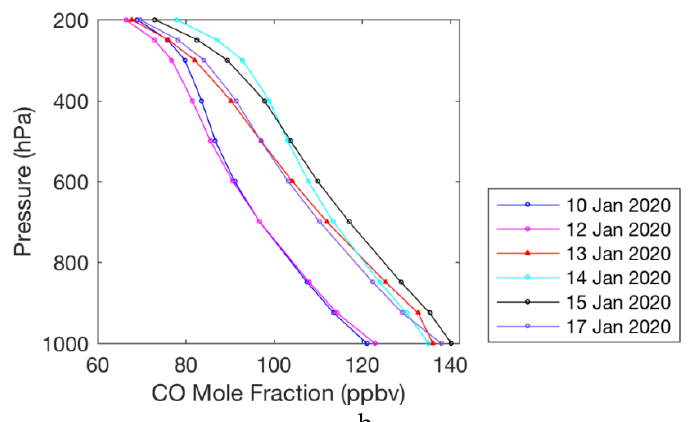
Figure 11. ( a ) Spatial distribution of the total vertical column of TROPOMI carbon monoxide (CO) before and after the eruption of the Taal volcano observed by Sentinel-5P. The red triangle indicates the geographic location of the Taal volcano. ( b ) AIRS CO mole fraction vertical profile around the time of the eruption of the Taal volcano.